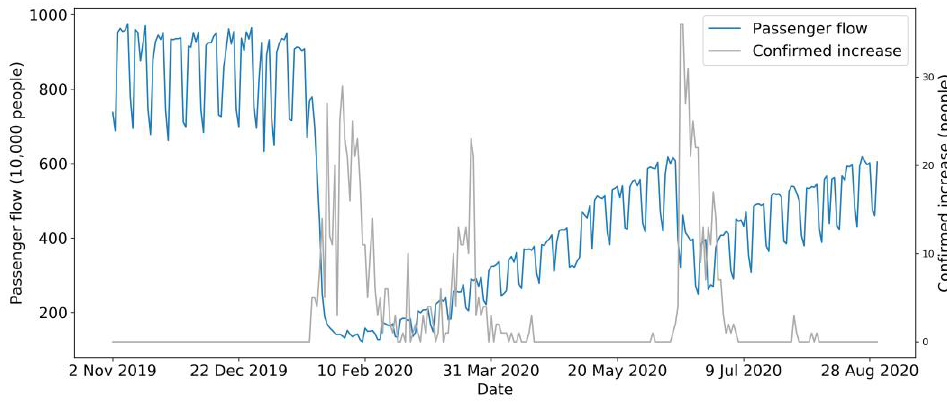
Figure 3. Curves of bus passenger flow and COVID-19 newly confirmed cases.